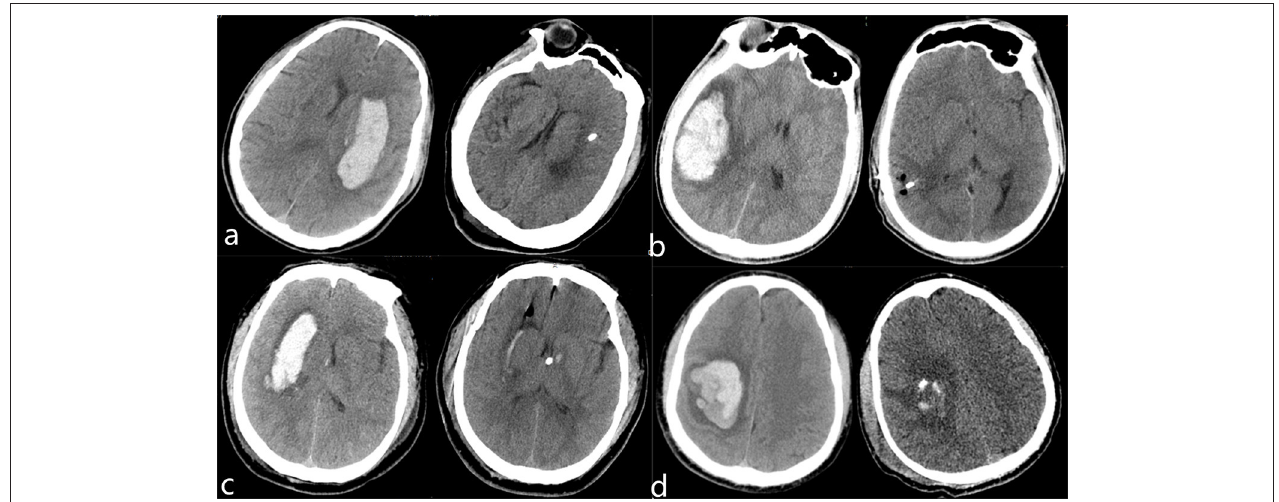
FIGURE 2 | Preoperative and postoperative CT images in robot-assisted neuroendoscopic hematoma evacuation combined ICP monitoring of representative patients with HICH (a–d) . (a) A 62-year-old female was presented with a headache and right hemiplegia for 4h. The hematoma was removed completely and the symptoms of headache were improved obviously. Continuous rehabilitation training was given to the patient after discharge. (b) A 54-year-old male presented with a headache for 10h. Preoperative CT shows right temporal lobe hemorrhage that has been evacuated totally. (c) A 65-year-old male was presented with consciousness disturbance for 5h. Preoperative CT scan shows right basal ganglia hemorrhage, which has been evacuated and we inserted a drainage tube with the Codman ICP monitoring probe to the ventricle. (d) A 73-year-old male was presented with left hemiplegia for 3h. Preoperative CT shows right parietal lobe hemorrhage, which has been evacuated and we inserted a drainage tube with the Codman ICP monitoring probe to the hematoma cavity. Continuous rehabilitation training was given to the patient after they were